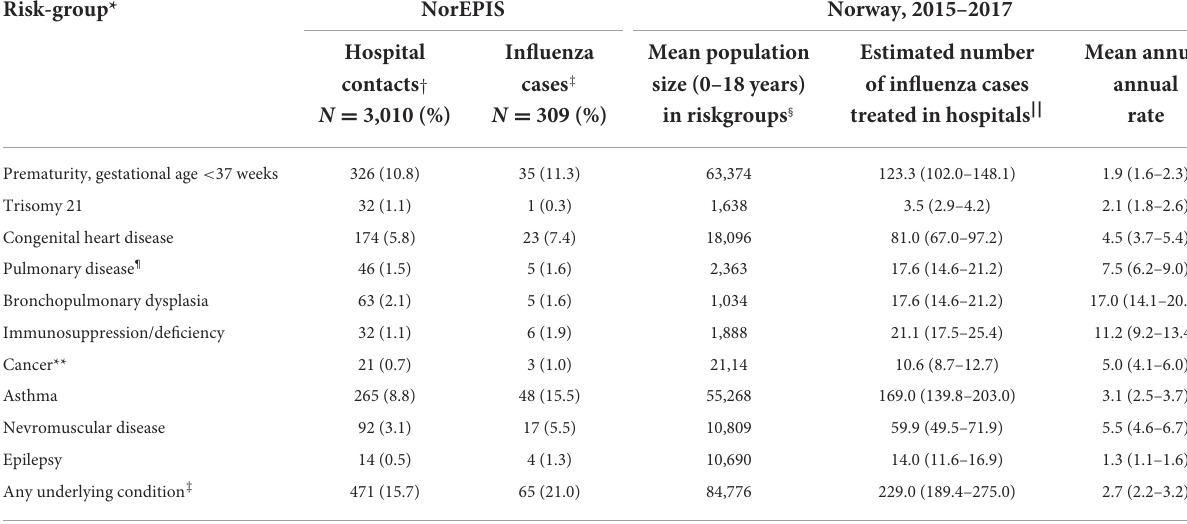
TABLE 3 Number of participants in high-risk groups of influenza, and mean annual rate of hospital contact per 1,000 children by risk-groups in children under 18 years of age in Norway, 2015–2017.